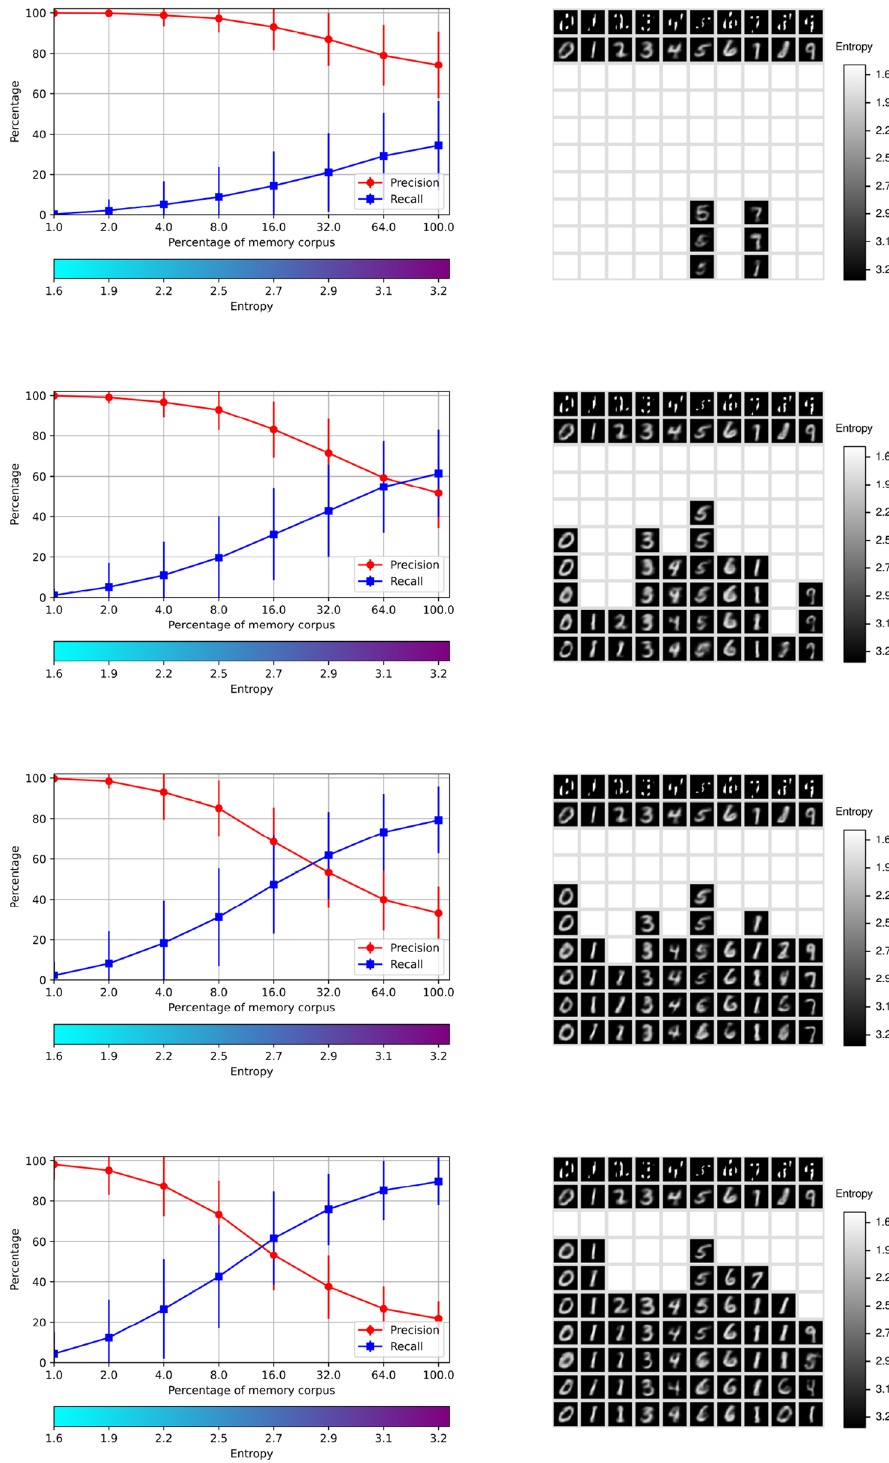
Figure 9. Memory retrieval with occlusions with vertical bars with relaxations of 1, 2 and 3